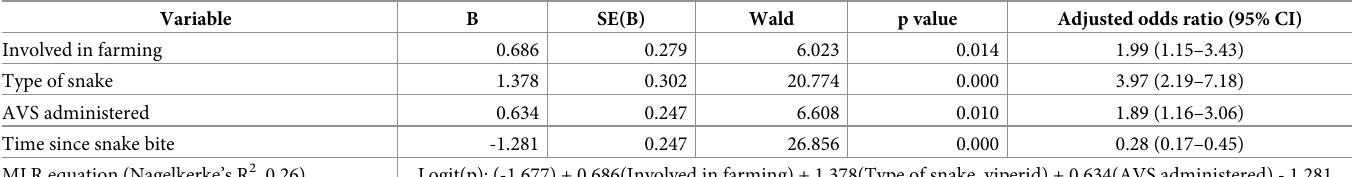
Table 6. Multivariable logistic regression analysis associations between non-specific symptoms and exposure variables.